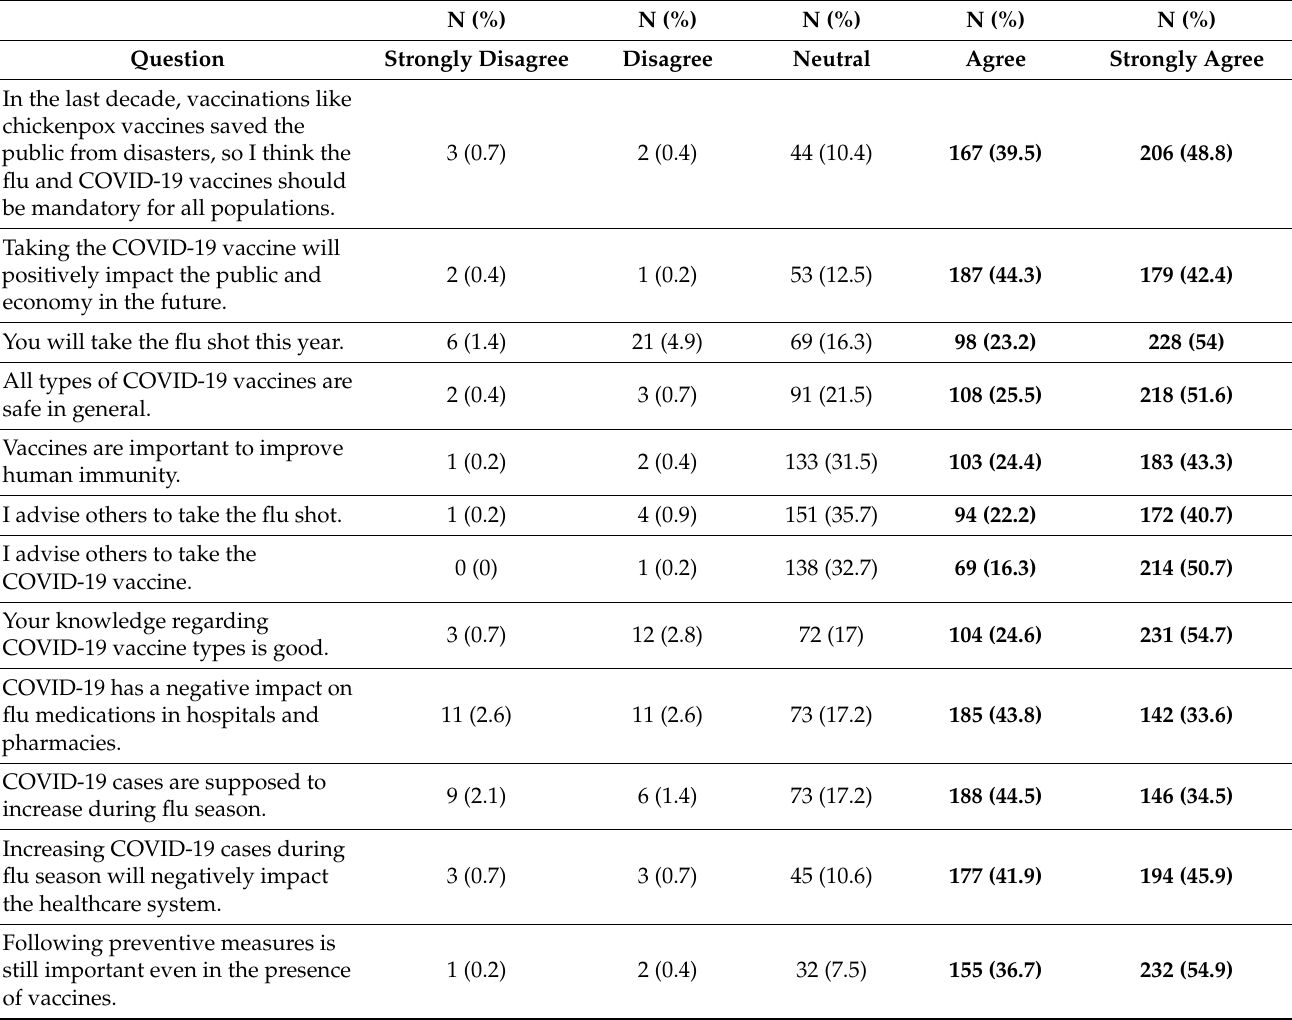
Table 2. Participants’ viewpoints towards the